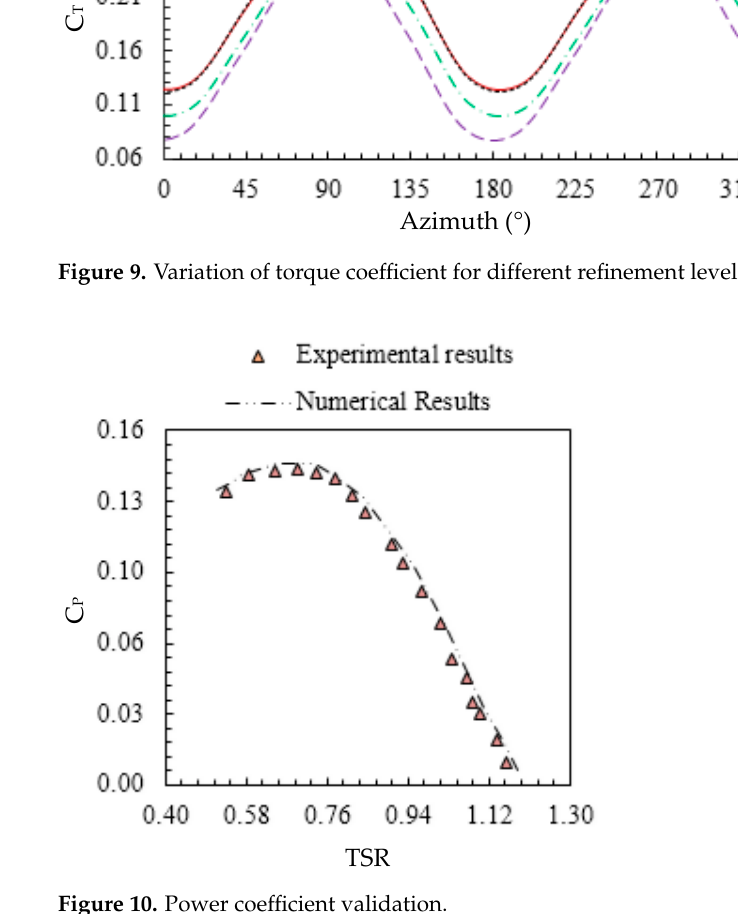
Figure 9. Variation of torque coefficient for different refinement levels of grid.